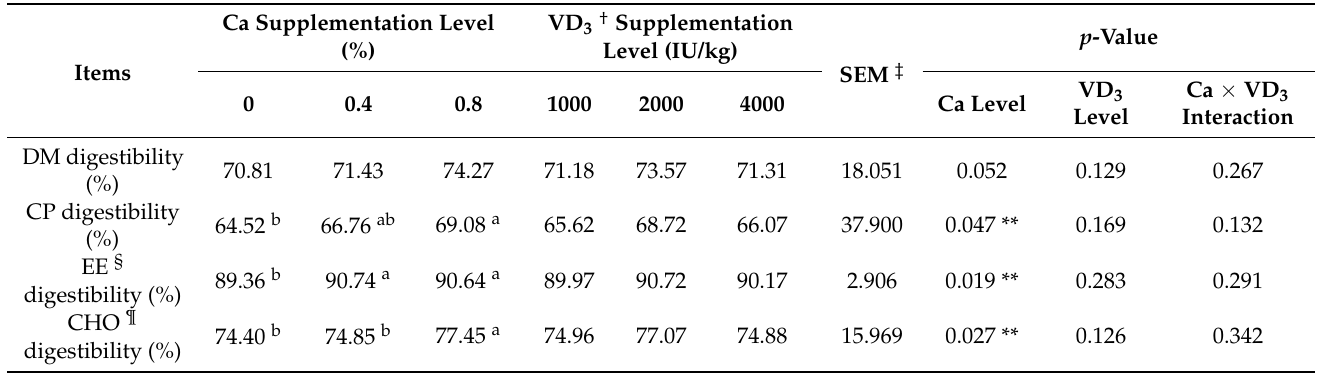
Table 3. Effects of dietary Ca and VD 3 supplemental levels on nutrient digestibility in growing blue foxes (LS means ±